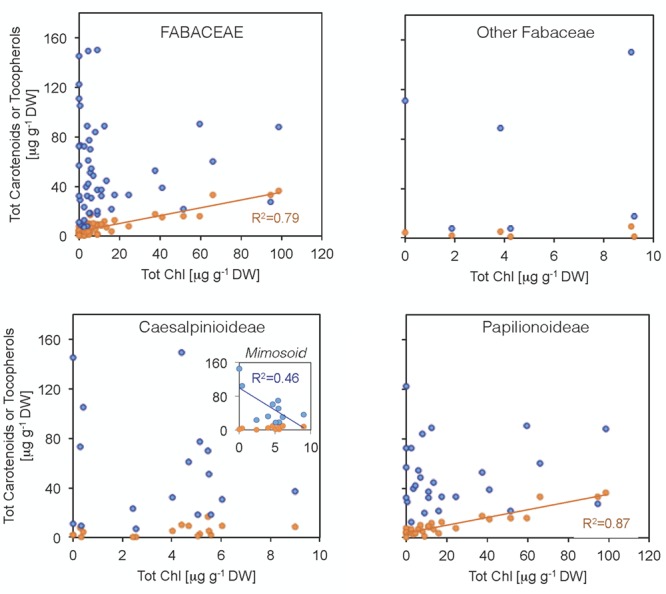
Relationship between total chlorophyll contents and (i) carotenoid (orange) or (ii) tocopherol (blue) contents in Fabaceae seeds. Each data point represents the mean value for a single species. Carotenoid and chlorophyll contents were positively correlated within the Fabaceae family due to strong correlation in the Papilionoideae subfamily. Tocopherol and chlorophyll contents were negatively correlated for the Mimosoid clade within the Caesalpinioideae. Fits a linear regression model and R2 values are shown for these cases (P < 0.05).